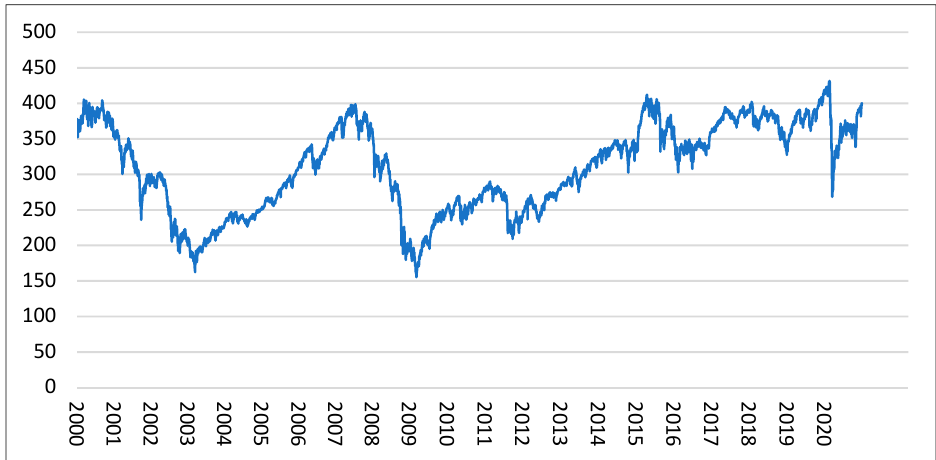
Figure 1. Change in the value of STOXX Europe 600 index during the observed period.